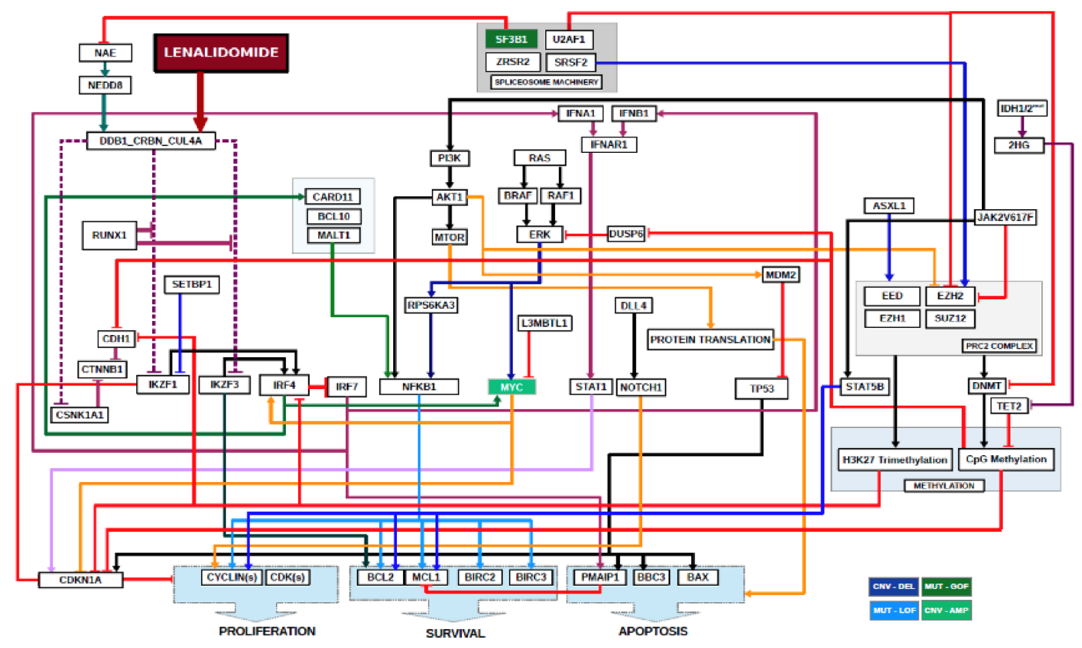
Figure 4. Computational Models of Non-Del(5q) MDS Patients with Abnormal Karyotype and Genetic Mutations. MDS patient-specific gene copy number variations, gain-of-function gene mutations, and loss-of-function gene mutations were computationally modeled and lenalidomide treatment digitally simulated. Two-dimensional maps showing intracellular pathways show the mechanisms of lenalidomide resistance in non-del(5q) MDS patients with a trisomy 8 karyotype and a mutation in SF3B1. Arrowed lines indicate agonistic relationship. Barred lines indicate antagnostic relationship. Line colorations are to assist the human eye in discriminating among the pathways. Somatic genes in dark blue boxes indicate copy number variation (CNV) deletions (DEL) derived from cytogenetic abnormalities. Somatic genes in light green indicate CNV amplifications (AMP) derived from cytogenetic abnormalities. Somatic genes with mutations resulting in loss of function (LOF) are indicated in light blue boxes. Somatic genes with mutations resulting in gain of function (GOF) are indicated in dark green boxes.